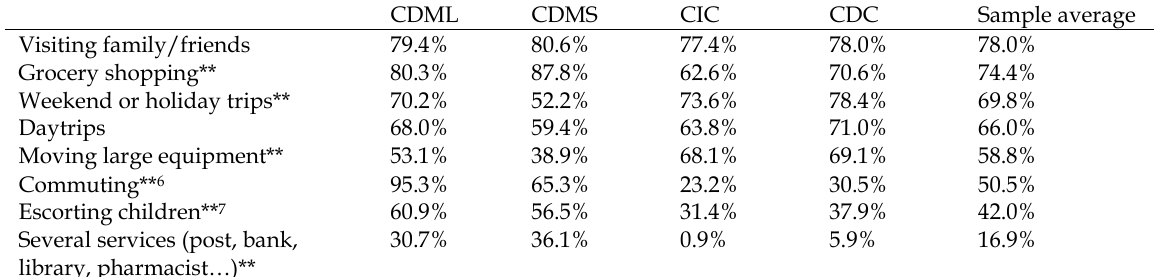
Table 7: Car trip purposes (%), per cluster (Assympt. Significance Pearson Chi-square **p<0.01) CDML CDMS CIC